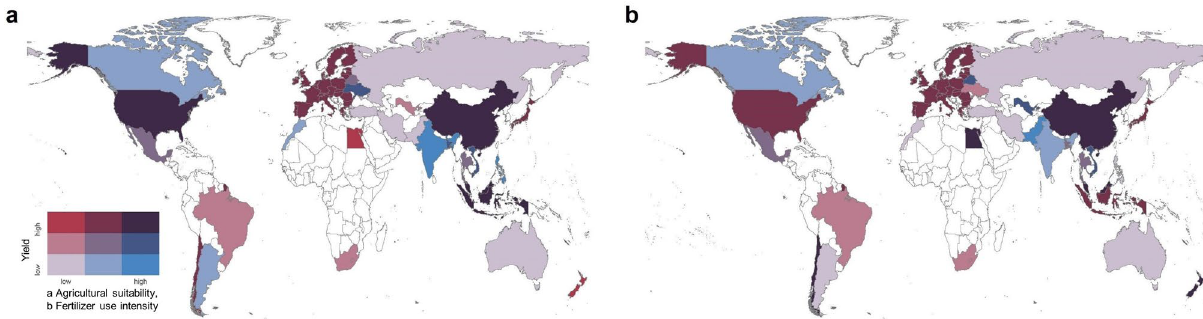
Figure 2. Bivariate choropleth maps of selected coproduction factors plotted against yield for the year 2014. Values were split into three tertiles; low, medium, high. ( a ) Agricultural suitability, ( b ) Fertilizer use intensity. Countries in white have no data for this year. Figure was created in R (version 3.6.1, https:// www.r- proje ct. org/) based on 58 .